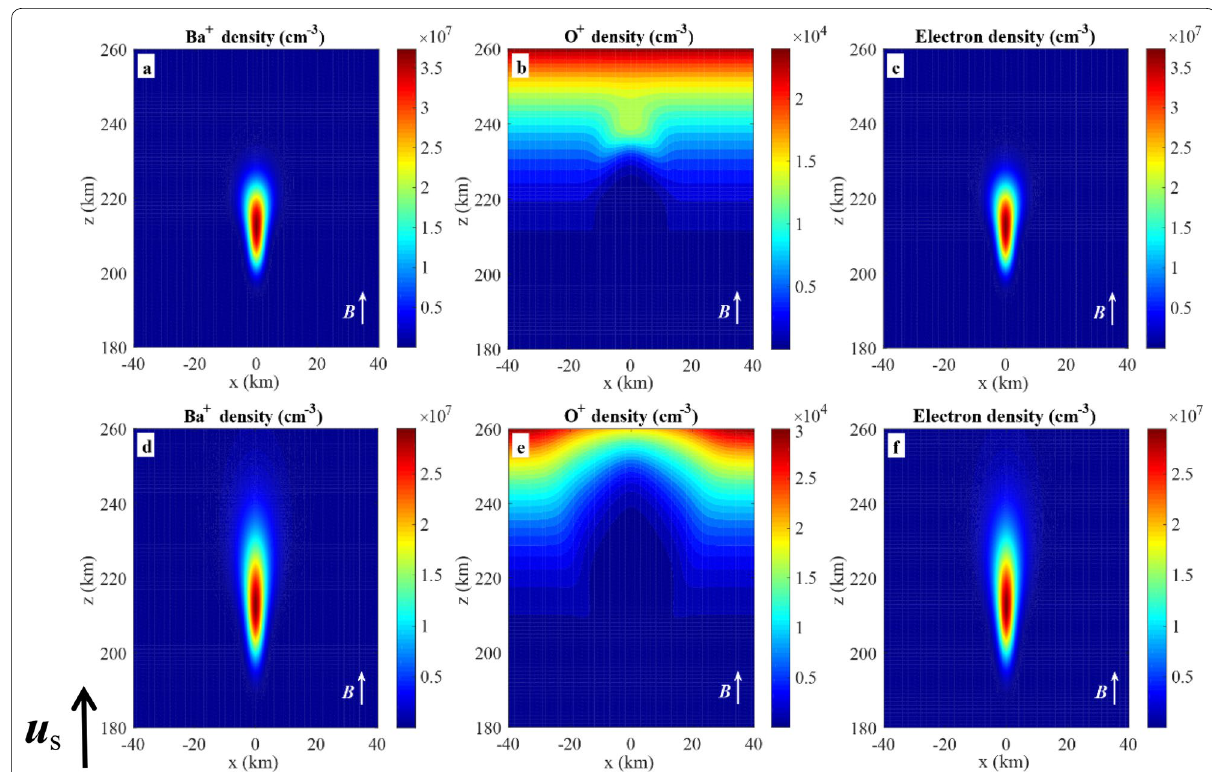
Fig. 8 The plasma cloud distribution in the x–z plane at t u s is 2 km/s along